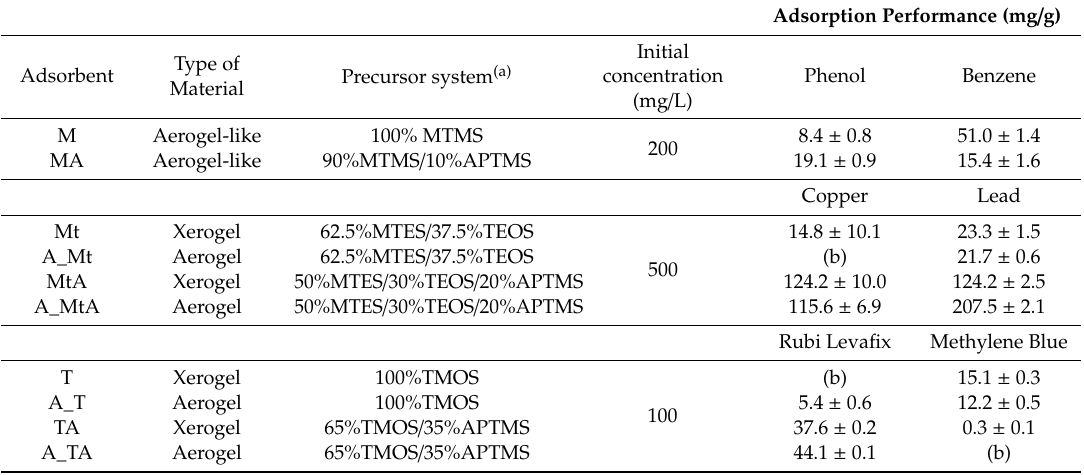
Table 1. Chemical systems nomenclature, type of materials, silica precursors proportion and the adsorption capacity of the adsorbents for the studied pollutants.